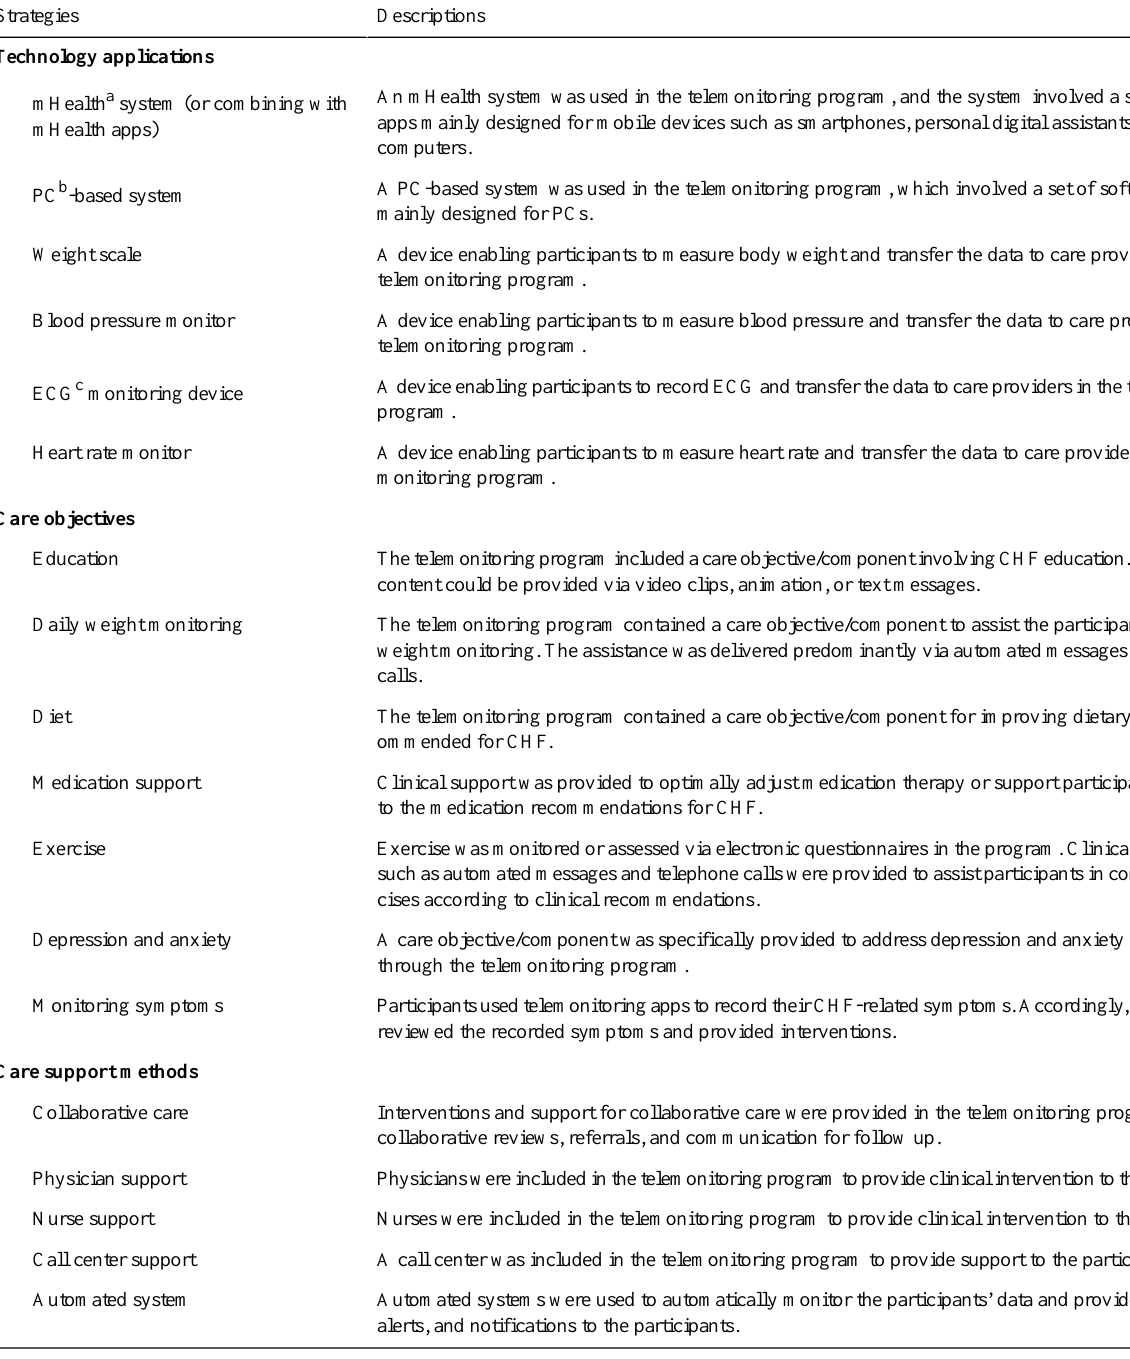
Table 1. Extracted telemonitoring strategies for the subgroup meta-analysis on telemonitoring interventions for chronic heart failure